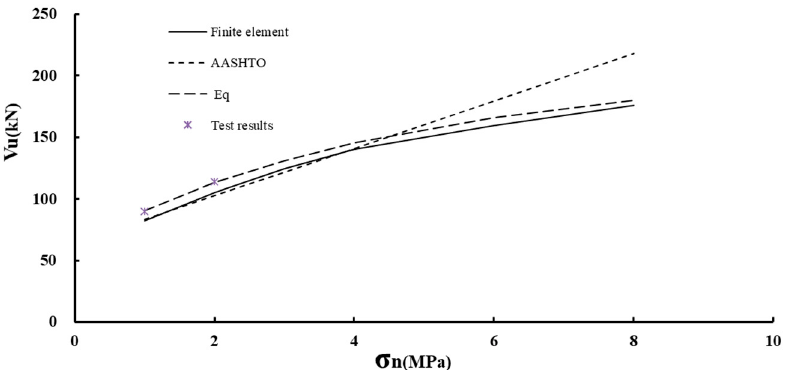
Figure 19. Comparison of the shear capacity predicted by di ff erent formulas and FE simulated values.